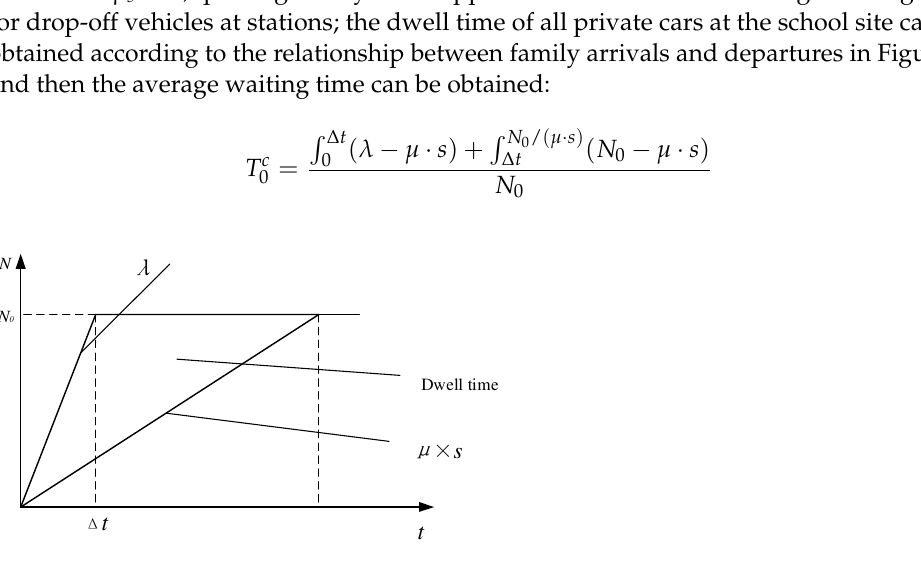
ρ > . Figure 4. The arrival and departure curves of private cars at the school site in the case of ρ s > s